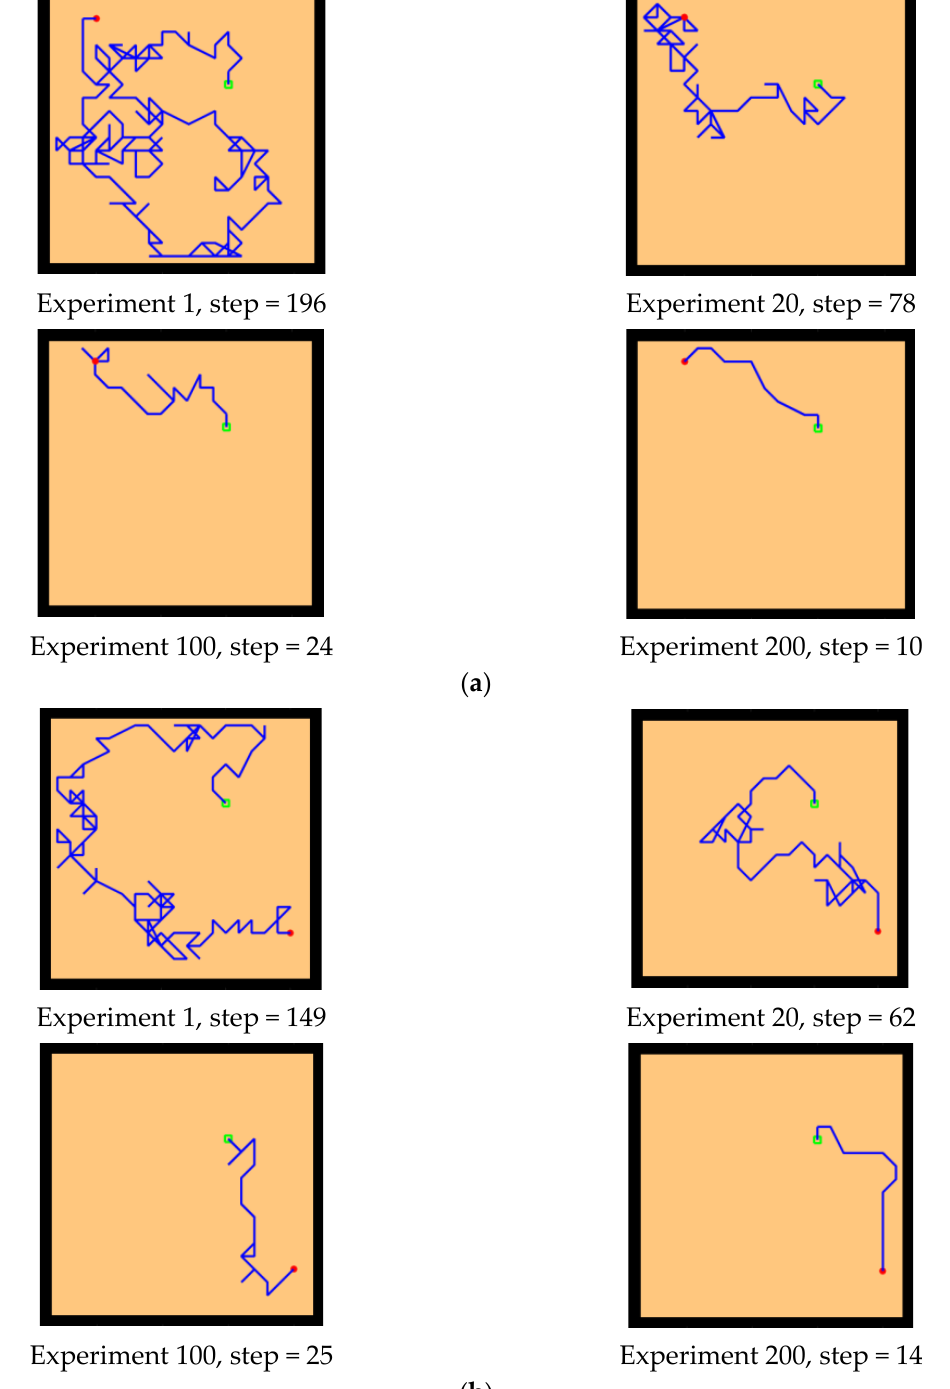
Figure 10. Basic experiment. The red circle is the starting position of the agent, the green square is the position of the hidden survival platform, and the blue line is the moving trajectory of the agent. The position of the starting point is changed, and the position of the survival platform remains unchanged. Two groups of experiments ( a , b ): ( a ) starting point a, ( b ) starting point B.